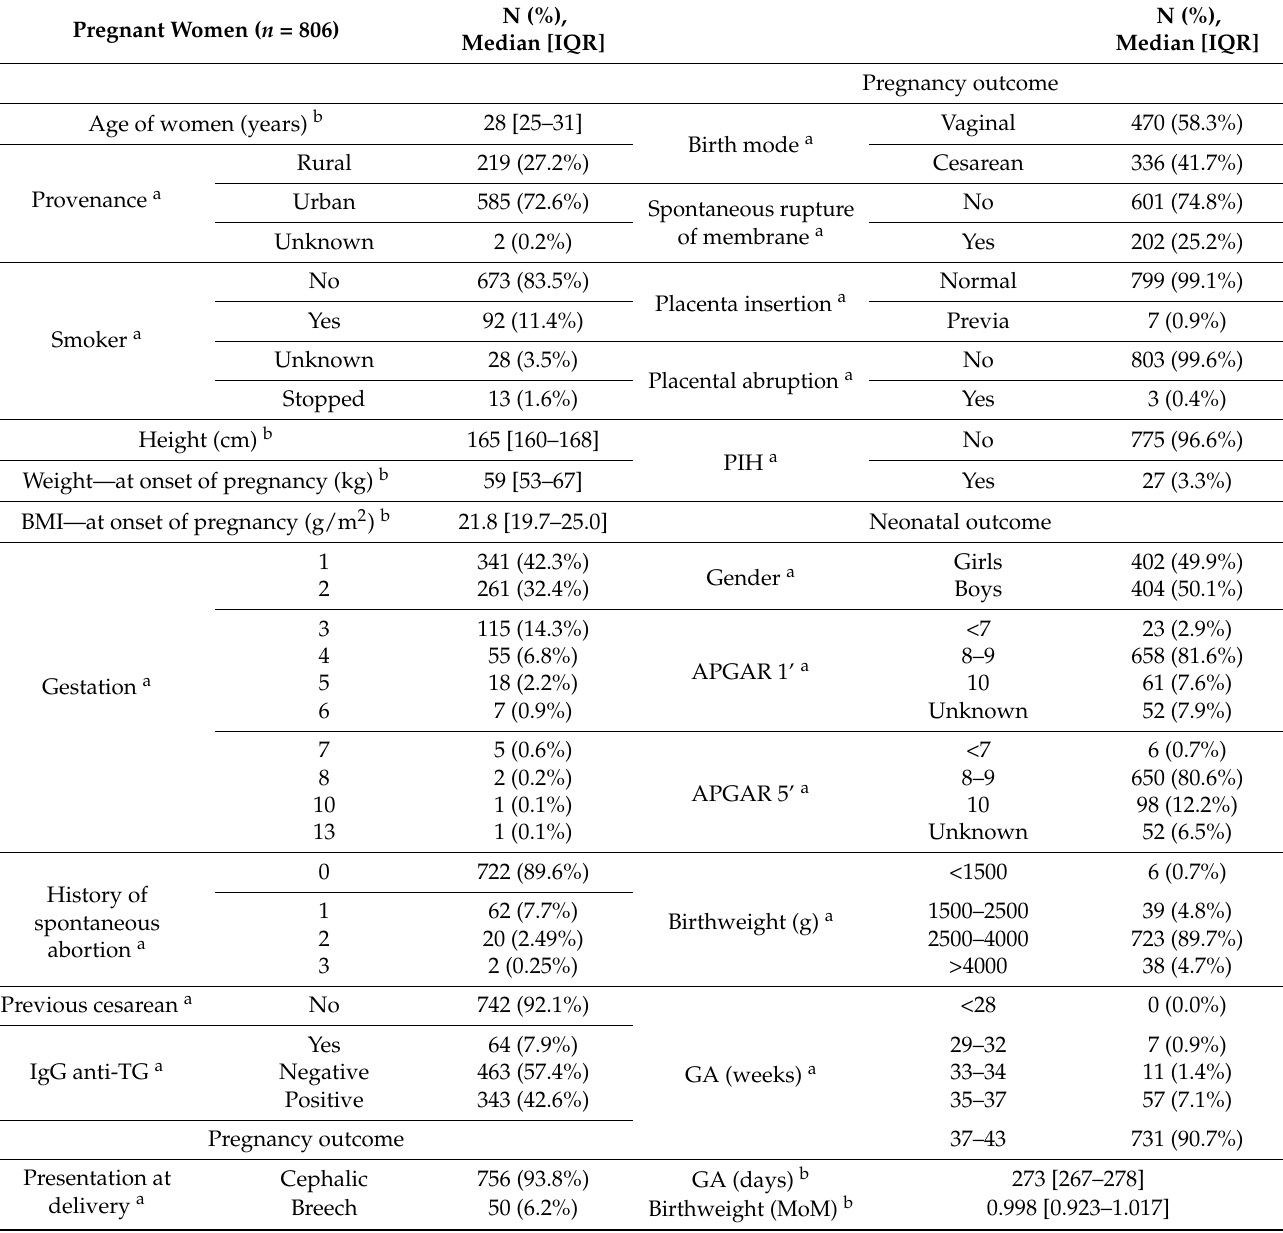
Table 1. Pregnant women’s baseline features: demographic, obstetrical history, pregnancy and neonatal